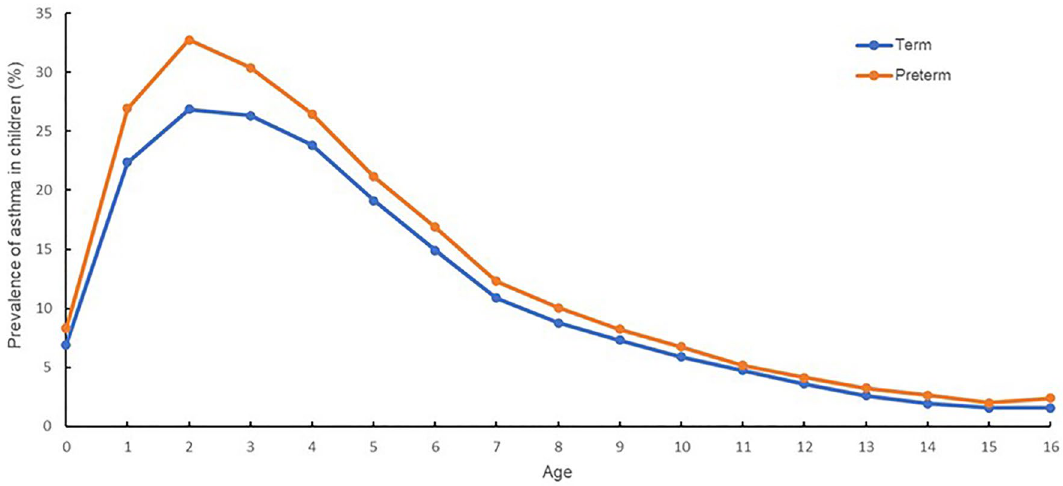
Figure 1. Asthma prevalence in preterm and term infants stratified by age. An orange line represents asthma prevalence in preterm infants stratified by age. A blue line represents asthma prevalence in term infants stratified by